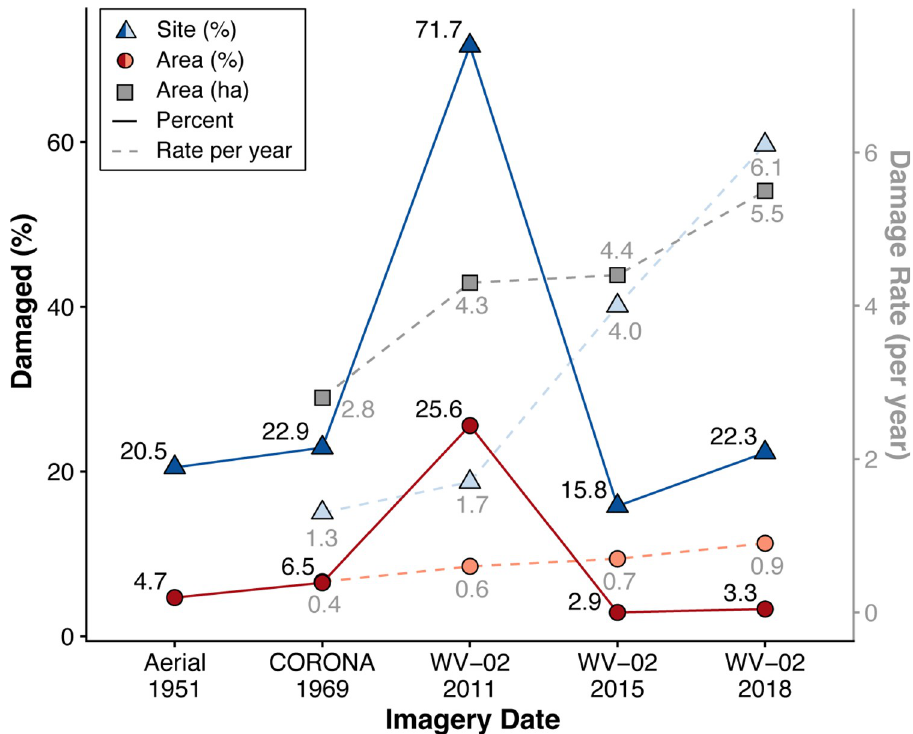
Fig 10. Graph showing the timing and rate of archaeological site damage between 1951 and 2018. The x-axis shows the date and type of the imagery. The left y-axis indicates the percentage (solid lines) of newly damaged sites (triangle) and site areas (circles) in each time step. The right y-axis indicates the rate of new damage per year based on the years elapsed between each new imagery dataset, including the percent sites (triangles), percent area (circles), and the number of new hectares (squares) damaged per